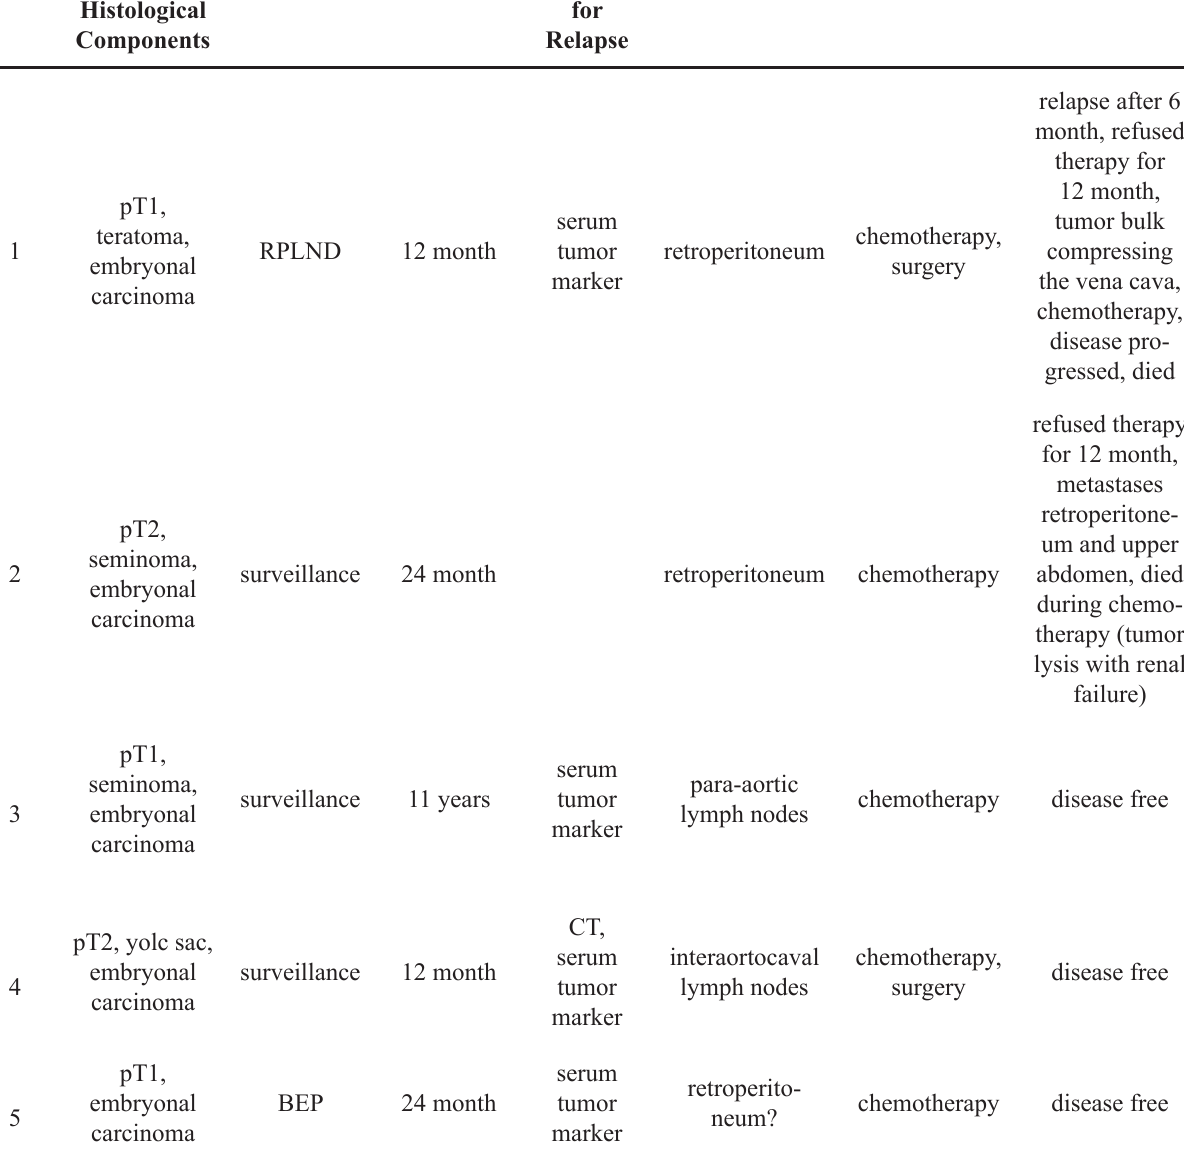
Table 2 – Recurrences in the follow-up of 52 patients with NSGCT stage I.